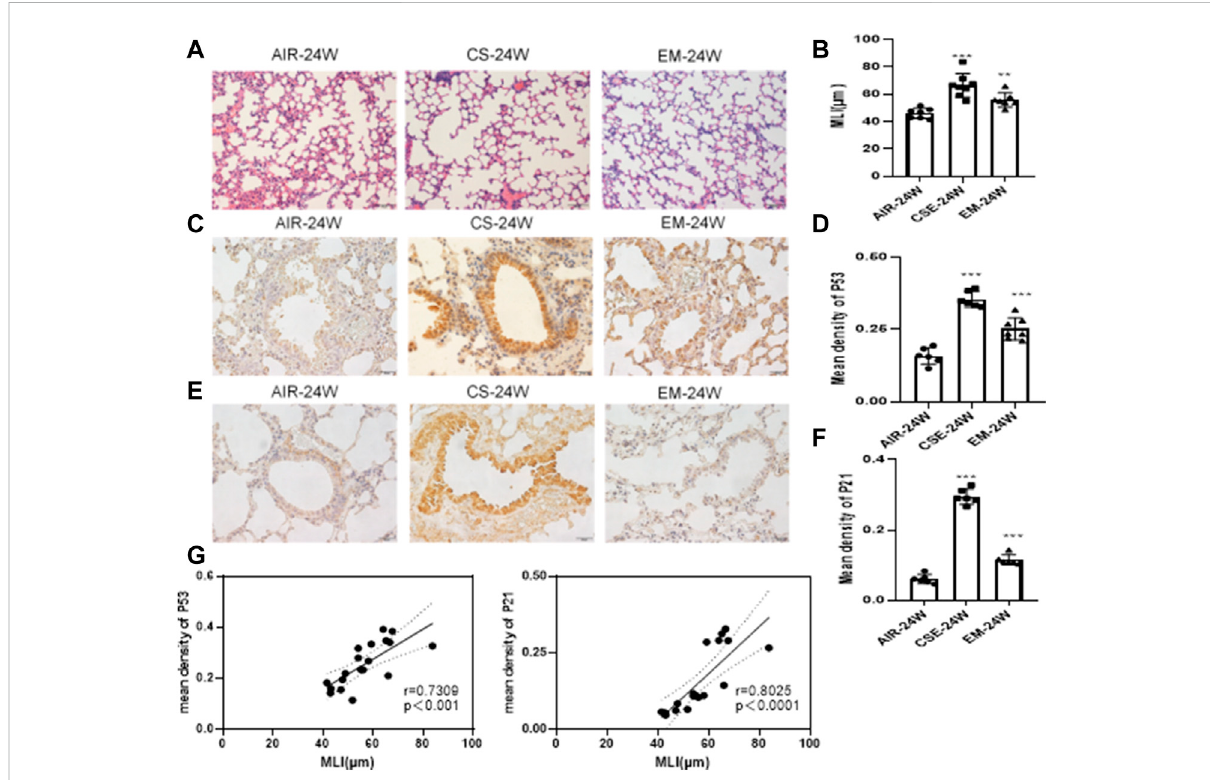
FIGURE 1 MLI and IHC staining of P53 and P21 in murine lungs (A – B) Alveolar MLI. Magni fi cation: ×200. (C – D) IHC staining of P53. Magni fi cation: ×400. (E – F) IHC staining of P21. Magni fi cation:×400. (G) Scatter plot of correlation analysis for mean density of P53 and P21 staining with MLI in